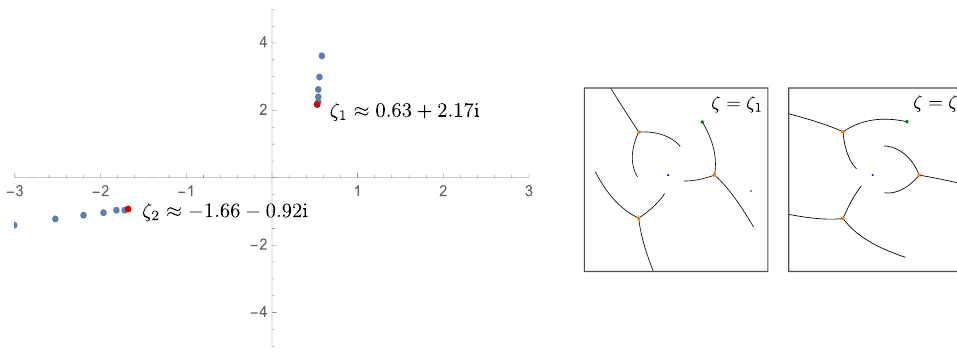
, marked in red, i .) i